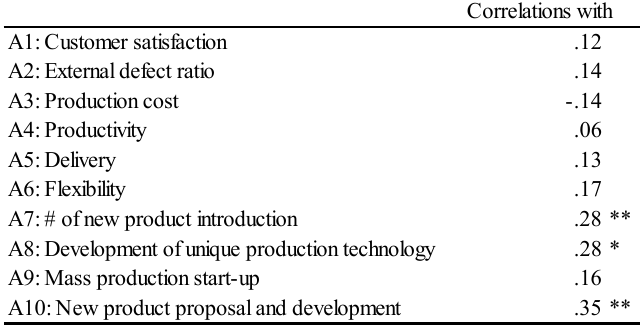
Table 3. Correlations between competitiveness and